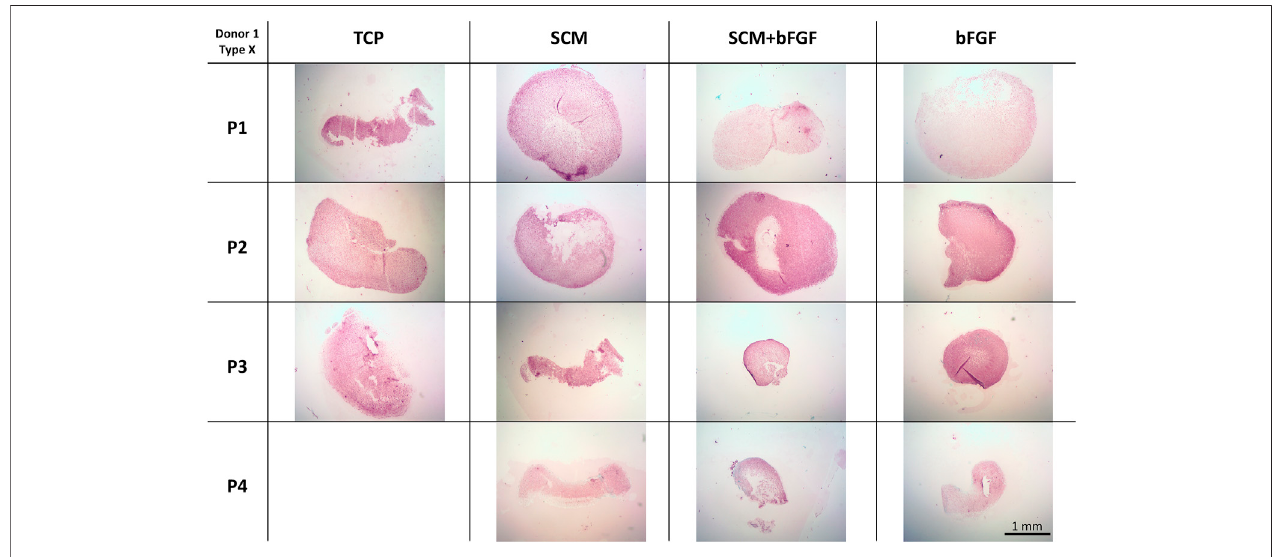
FIGURE 10 | Cartilage aggregate images showing type X collagen staining. Sections of cartilage aggregates from a single donor over the four passages in each condition are shown here stained for type X collagen. All at the same scale, scale bar 1 mm. See Supplementary Figures S11 – S13 for other donors.